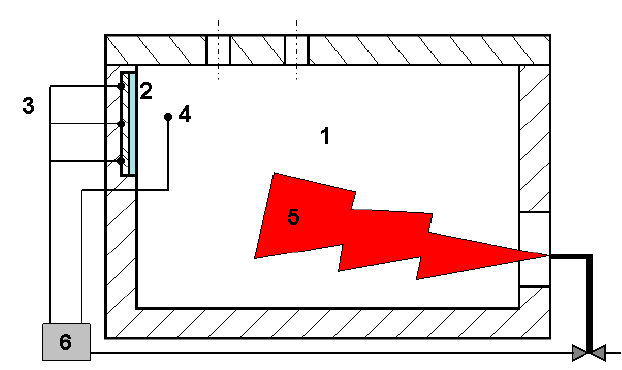
Figure 2. A scheme of the propane gas flame-heated programmable furnace used for the thermal insulation tests of the coatings: (1) the furnace chamber, (2) a steel substrate with the intumescent coating, (3) three thermocouples measuring temperature of the steel substrate, (4) a thermocouple measuring temperature of the furnace chamber, (5) a propane gas burner and (6) a temperature control unit.